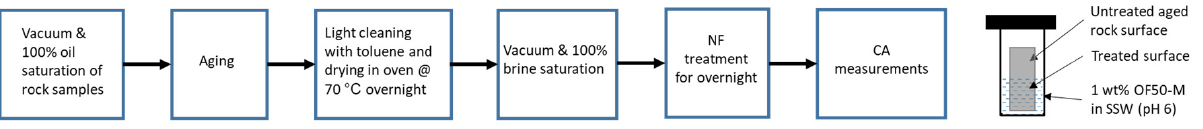
Figure 2. Procedure to prepare rock samples for contact angle measurements.